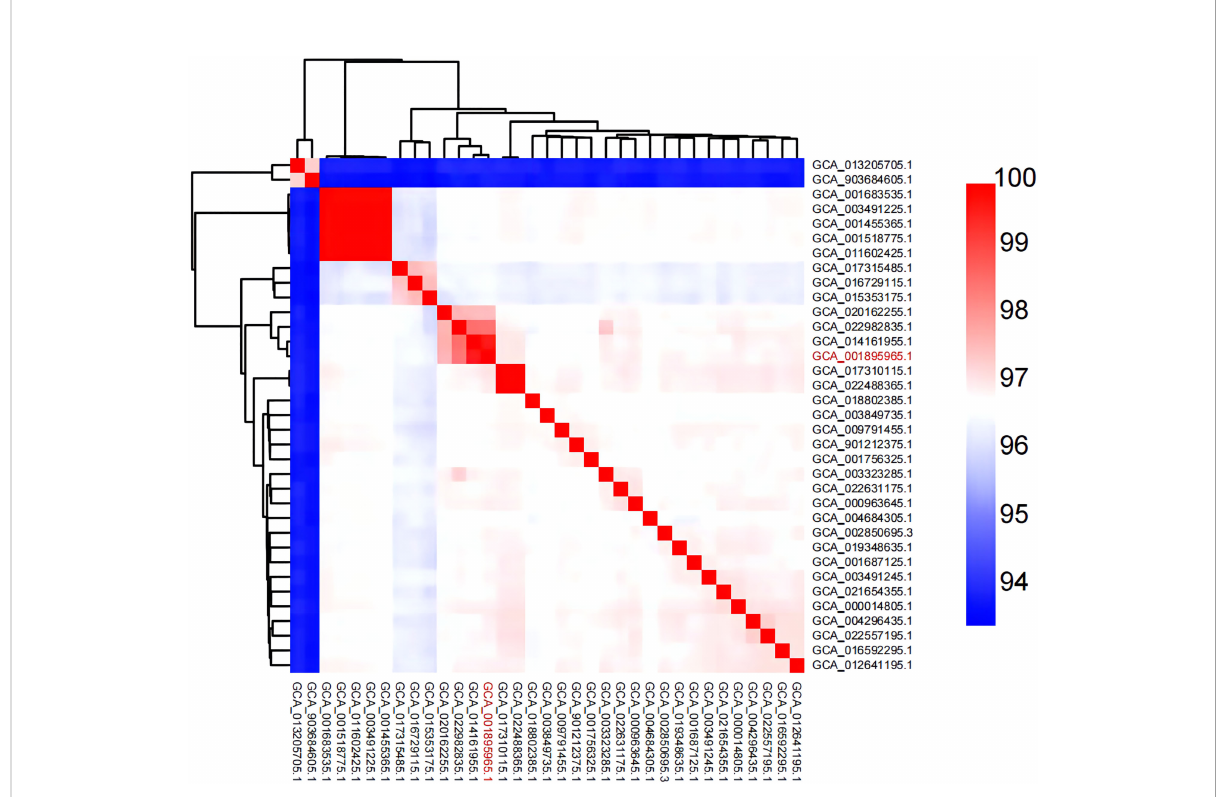
FIGURE 5 Heat map of ANI pairings between any two genomes of MX16A (in red font) and other A. hydrophila strains downloaded from NCBI database.